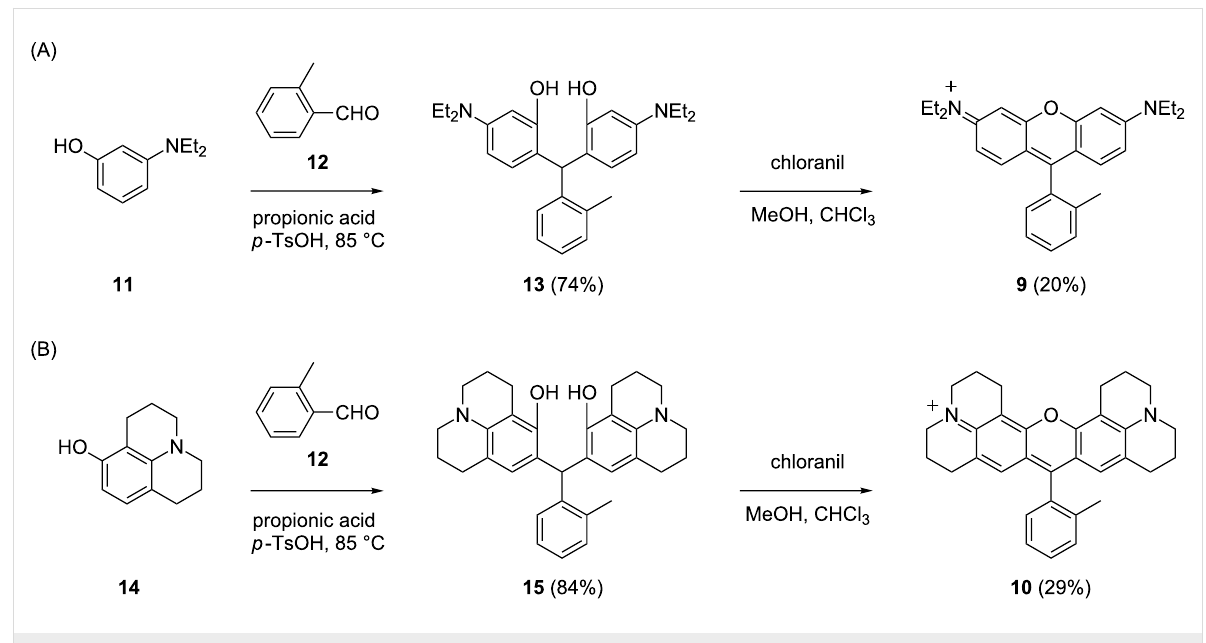
Scheme 1: Synthesis of the HRB 9 and HR101 10